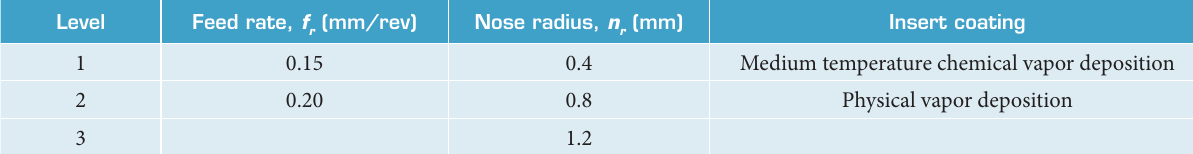
Table 1. Variable parameters and their